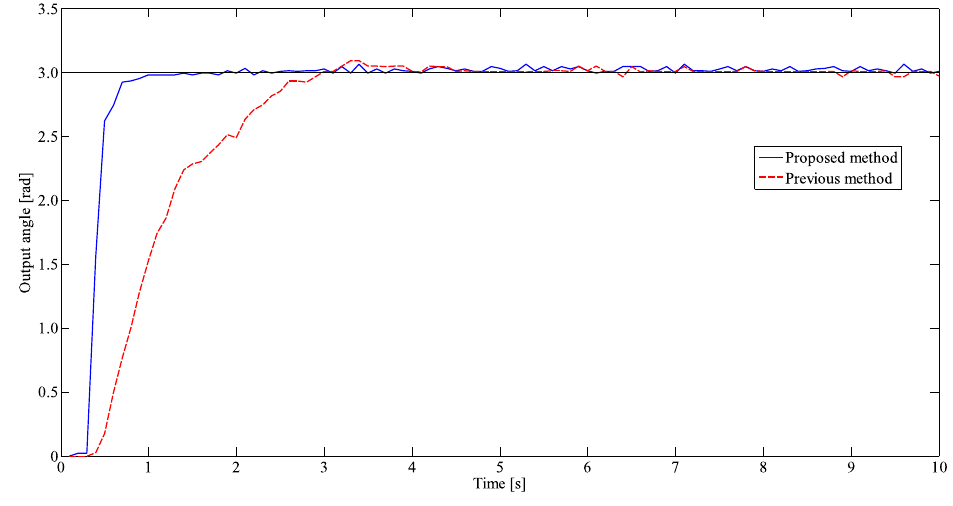
Figure 12. The experimental result of the proposed method compared with previous method.